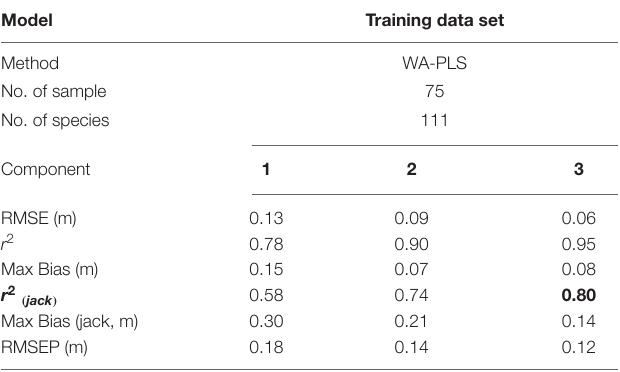
TABLE 3 | Average, density and diversity of the most abundant living/dead foraminifers found on the intertidal sabkha of Al-Kharrar Lagoon. Living assemblage Death assemblage Calcareous